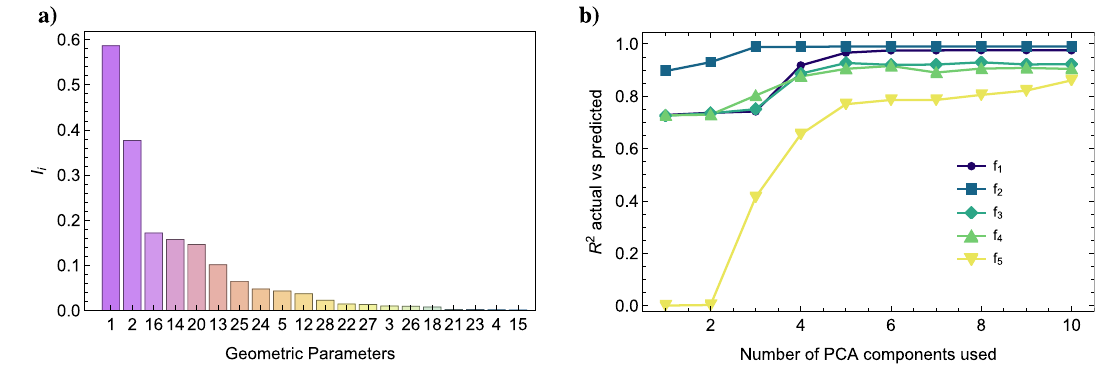
Figure 4. ( a ) Feature importance measured trough I i . The geometric parameters are here sorted in decreasing order of importance. As we can see, only few parameters carry a significant amount of information about the eigenfrequencies. Interestingly, the parameters that correlate with frequency 5 are not the same that correlate the remaining frequencies. ( b ) Accuracy of the prediction model based on the PCA components of the outline instead of the geometric parameters, each line corresponds to a different mode frequency.